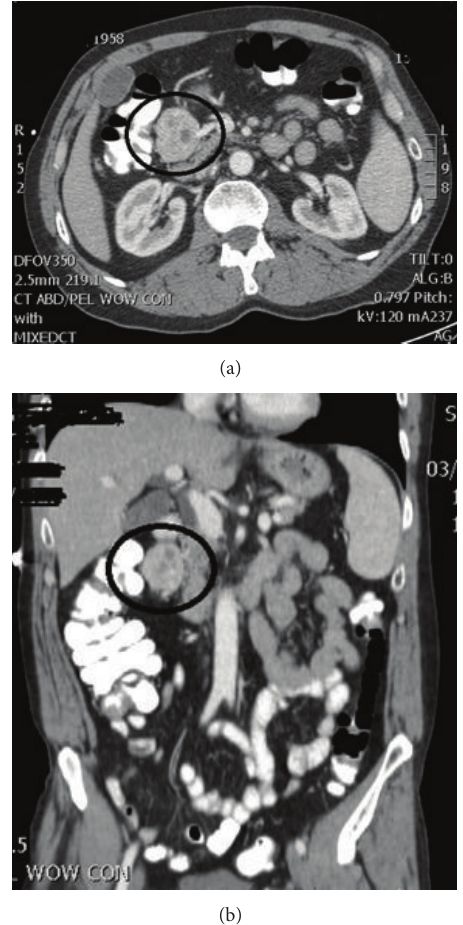
Figure 1: CT scan of abdomen and pelvis with contrast in (a) axial view and (b) coronal view showed well-defined 4.5 cm enhancing mass of mesocolon which was located anterior to descending duodenum, posterior to gastric antrum, and just medial to the hepatic flexure of